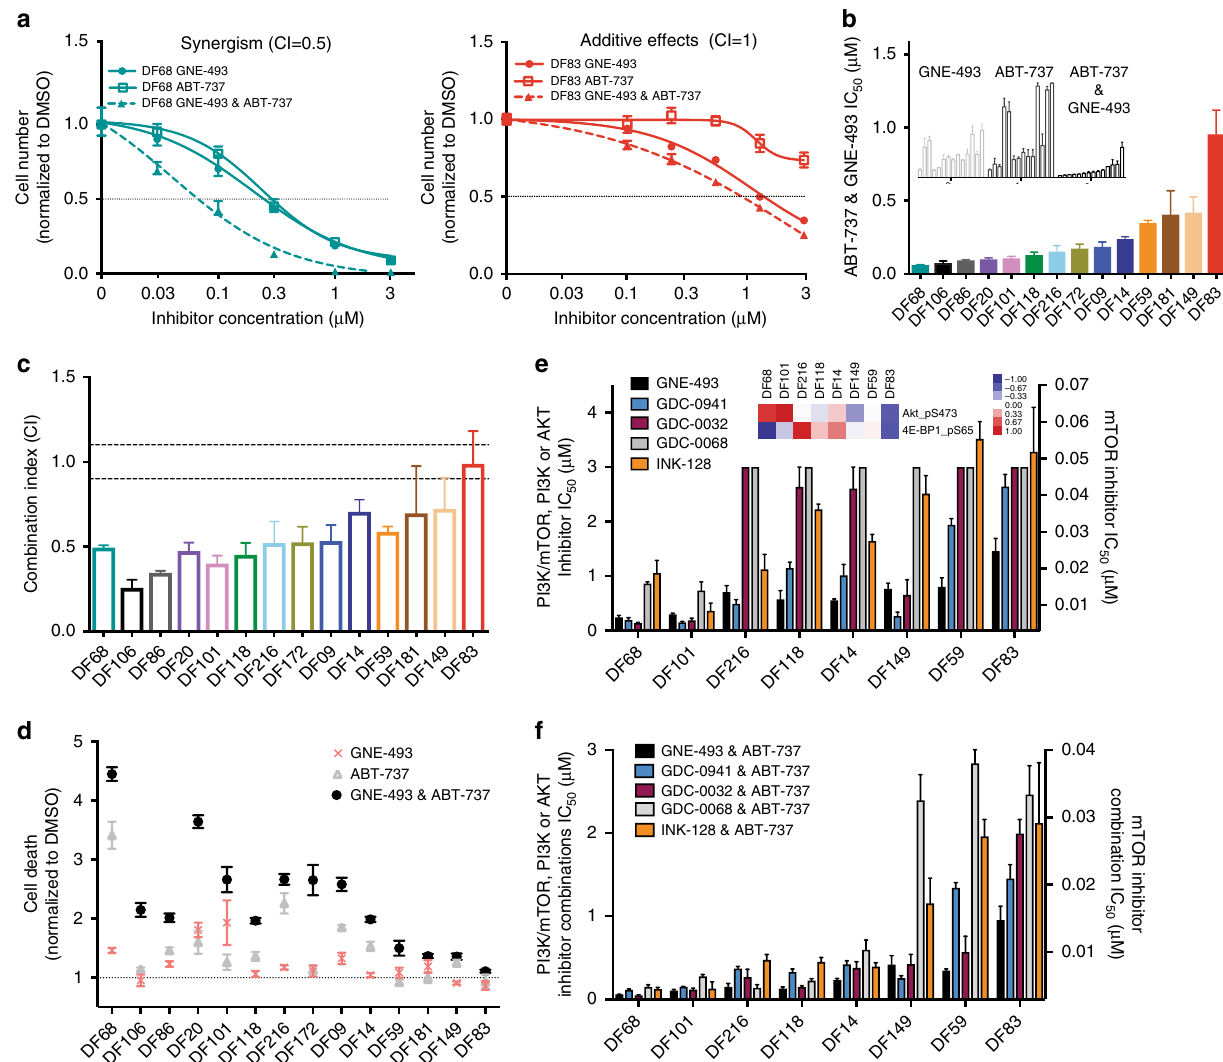
Fig. 3 Inhibition of PI3K/mTOR and BCL-2/BCL-X L is synergistic and induces signi fi cant cell death in vitro. a Representative examples of synergistic (DF68) and additive effects (DF83). Data is representative of three independent experiments and error bars represent SEM ( n = 6 wells). b Ranking of PDX models based on their IC 50 values for the GNE-493 & ABT-737 combination. Inset shows IC 50 values for single-agent and drug combination. Data is derived from experiment in a and Supplementary Fig. 3A, B. c Combination indices computed using the Chou – Talalay analysis for all 14 PDX samples. Values are averages across three independent experiments and error bars represent SEM. d Analysis of cell death induced by single agent and combined GNE-493 and ABT-737 (compared to DMSO) 96 h after drug exposure (0.3 μ M of each drug) using laser scanning cytometry. Data is representative of three independent experiments and error bars are SEM ( n = 6 wells). e , f IC 50 values for GDC-0032 (PI3K- α / γ / δ inhibitor), GDC-0941 (pan-PI3K inhibitor), INK- 128 (mTORC1/2 inhibitor) and GDC-0068 (AKT inhibitor) as single agents e and in combination f with ABT-737 compared to the GNE-493 and ABT-737 combination in a panel of eight PDX models. Heatmap shows phospho-AKT and phospho-4EBP1 protein levels (data derived from Fig. 1d). Data is derived from Supplementary Fig. 4 and represents an average of three independent experiments (error bars represent SEM, n =